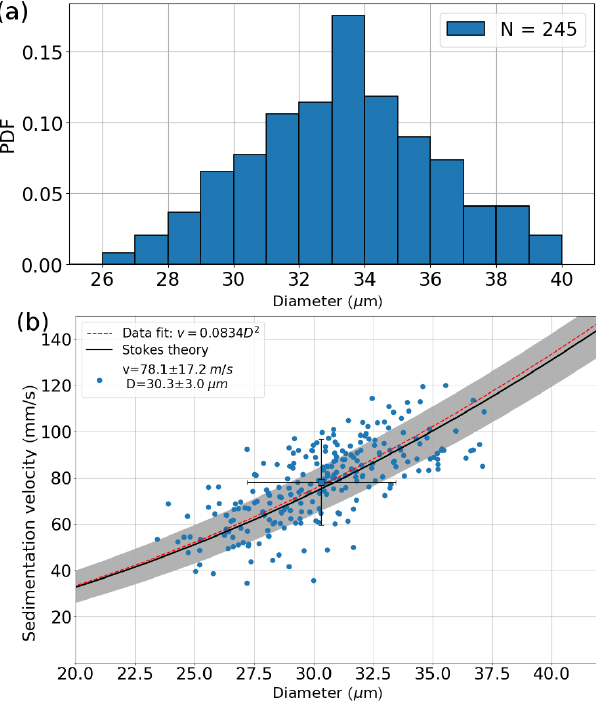
Figure 3. (a) Distribution of measured calibration sphere diame- ters before size corrections. (b) Fall velocity as a function of (size- corrected) calibration sphere diameter for single calibration mea- surement fall tracks, quadratic fit as red dashed curve. The black curve shows the velocity expected from Stokes’ law as a function of glass sphere diameter for ρ g = 2500kgm − 3 with uncertainty as gray shading. The black marker shows mean and standard devia- tions of the measurement